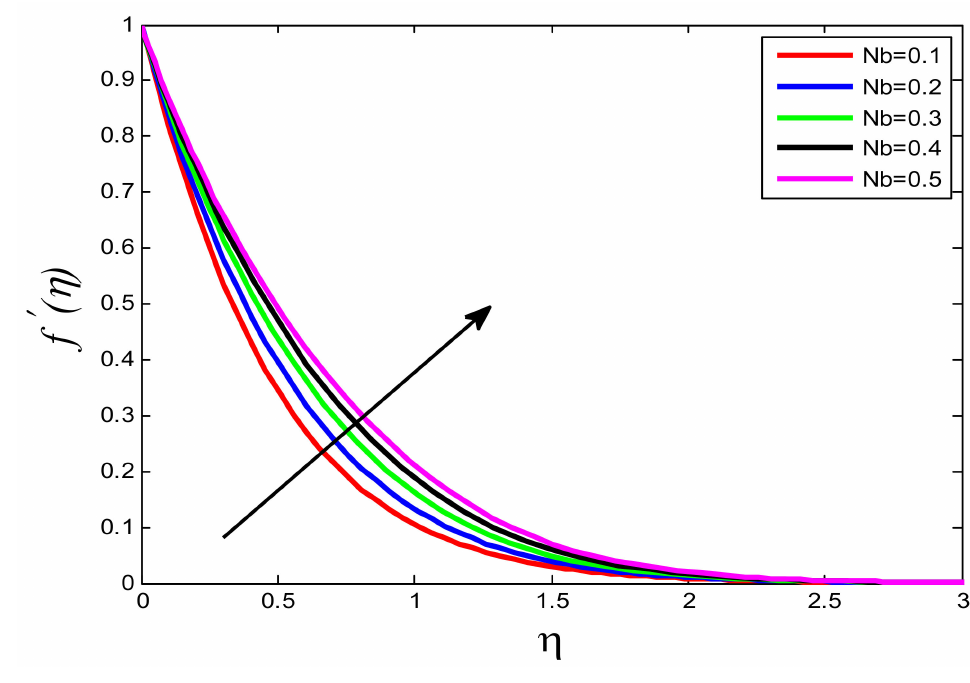
Figure 18. Influence of Nb on f (cid:48) ( η ) .